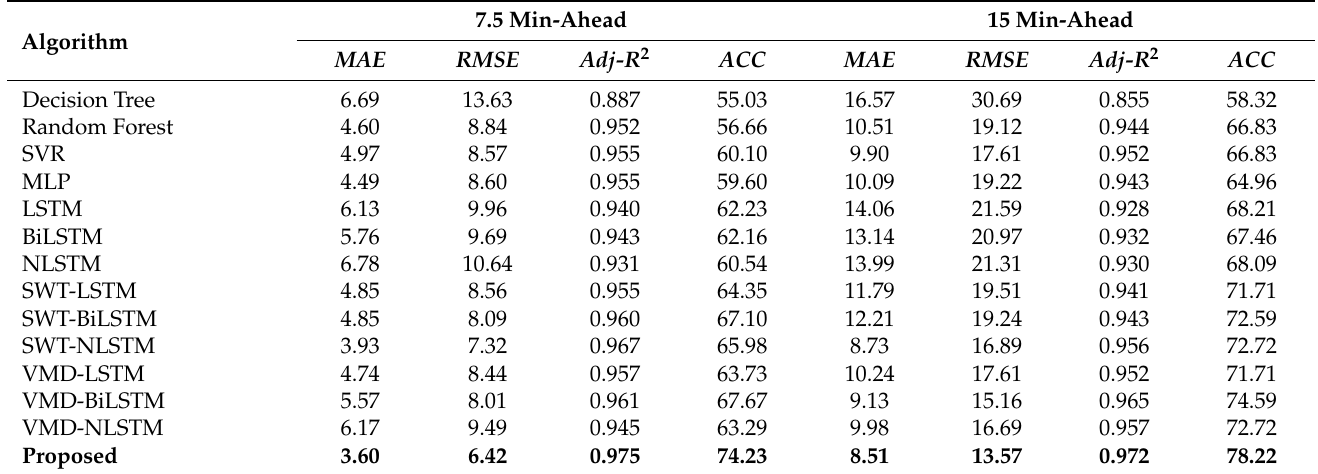
Table 6. Performance comparison of different prediction methods based on dataset